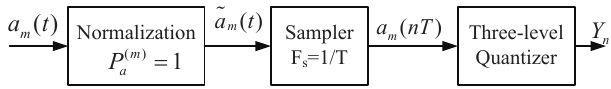
Figure 5. The proposed 1.5-bit FM demodulator can be interpreted as a sampler for the audio signal a with sampling m ( t ) frequency F followed by a three-level s = 1 /T